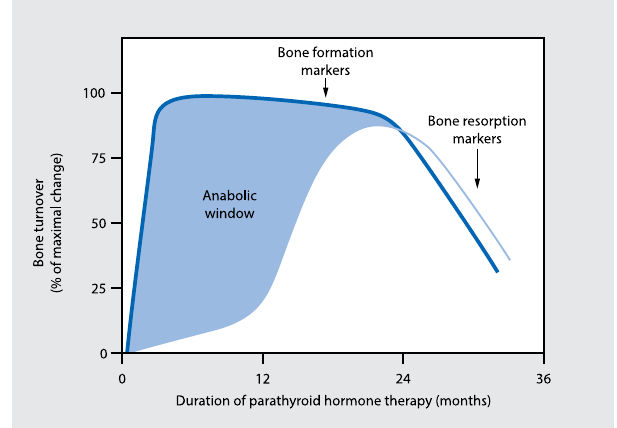
Figure 8: The anabolic